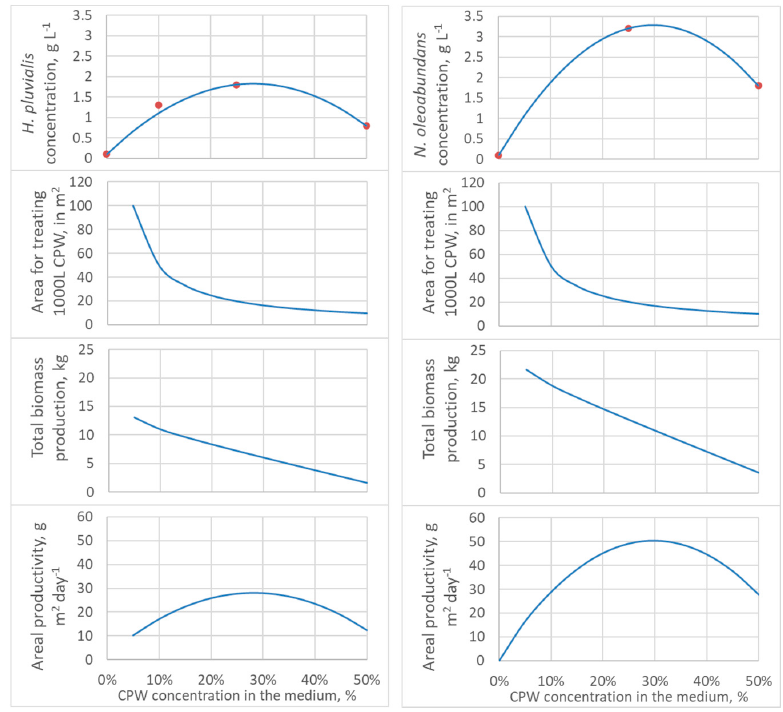
Figure 2. Model estimates as a function of CPW concentration (from 0 to 50% effluent): Dry cell weight, the area necessary for treating 1000 L of filtered CPW, total biomass production from 1000 L of filtered CPW, and productivity per pond area, considering high-rate ponds of 20 cm depth and 13 days of batch culture. Left curves, H. pluvialis ; right curves, N. oleoabundans . Red dots are experimental values.